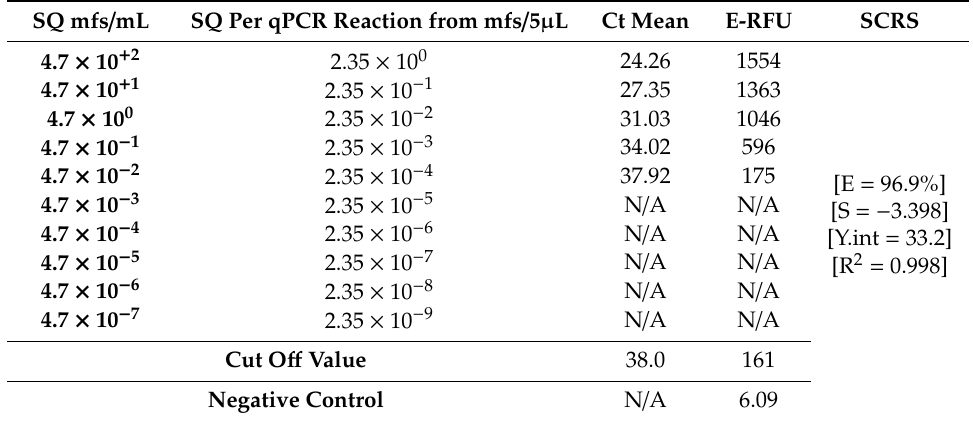
Table 4. Sensitivity and Assay Performance Characteristics of the Duplex COI-based System in Detecting D. immitis